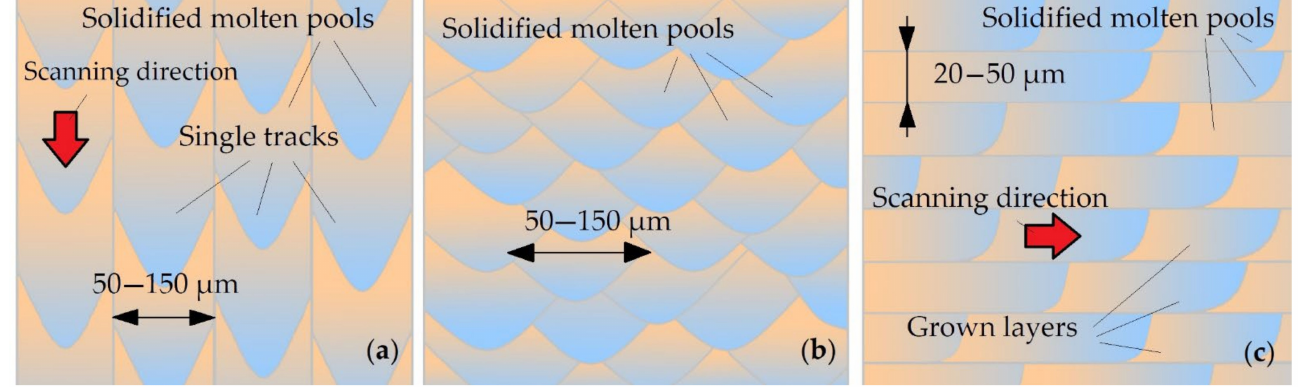
Figure 1. The schematic structure of the metal product obtained by LPBF: ( a ) Top view; ( b ) Cross section; ( c ) Longitudinal